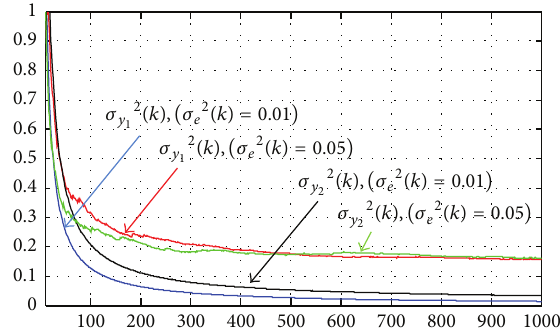
2 (𝑘) and 𝜎 2 (𝑘) with 𝜎 𝑒2 = 0.01 𝑦 2 1